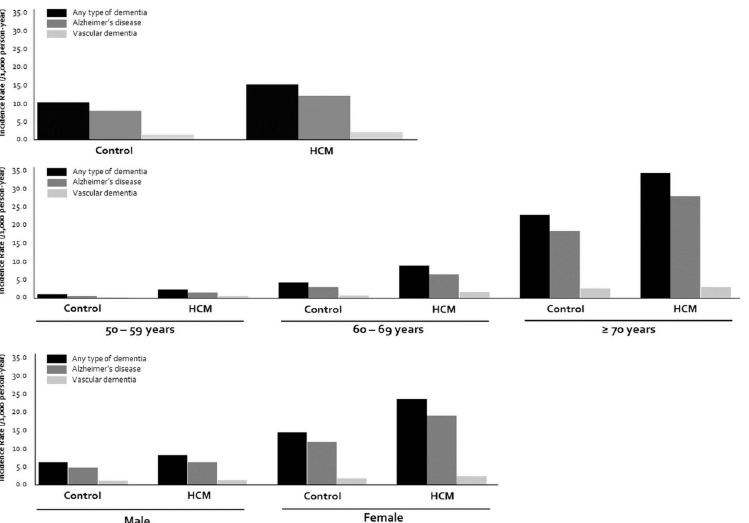
Fig 2. Comparison of incidence rates of any dementia, AD, and VaD according to age and sex. Generally, incidence rate of dementia was higher in patients with HCM than that in controls: AD was significantly frequent, whereas VaD did not have statistical significance. In age- and sex-stratified analyses, the incidence of dementia was higher in the elderly and women, regardless of dementia type. A consistent trend was found to have a higher incidence of any dementia and AD but a similar incidence of VaD in the HCM group. AD, Alzheimer’s disease, VaD, vascular disease, other abbreviation as Fig 1. https://doi.org/10.1371/journal.pone.0269911.g002 Table 2. Incidence and the risk of dementia in subjects with vs. without HCM. Any type of dementia Alzheimer’s disease Vascular